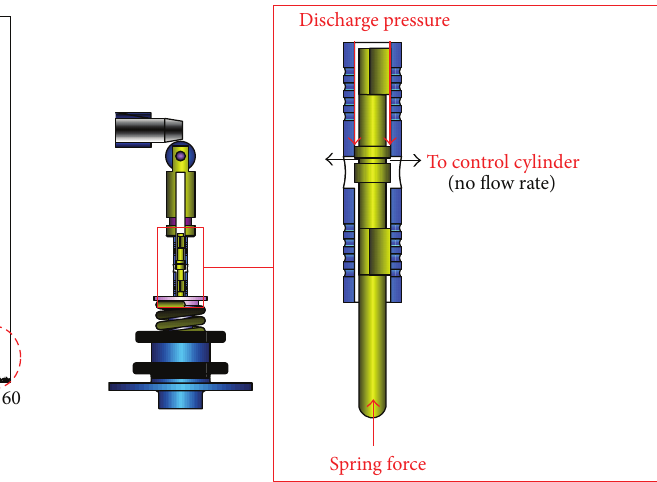
Figure 9: Schematic of constant power regulator in the case of maximum flow rate.